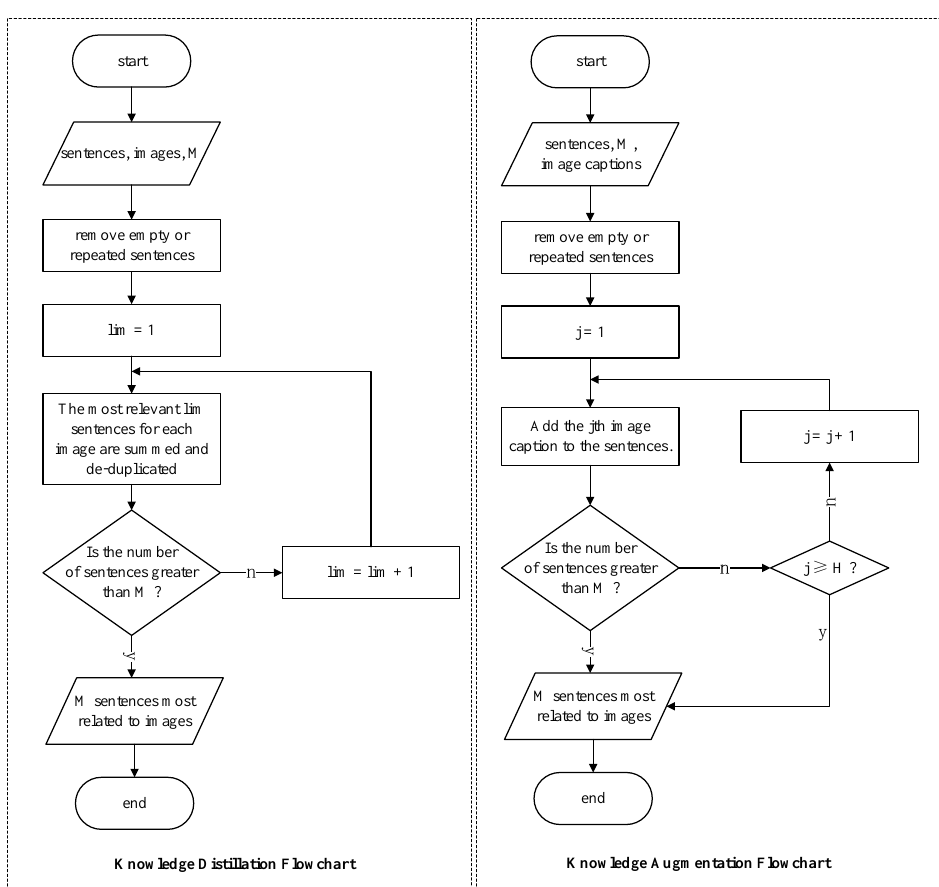
Figure 3. Knowledge distillation/augmentation